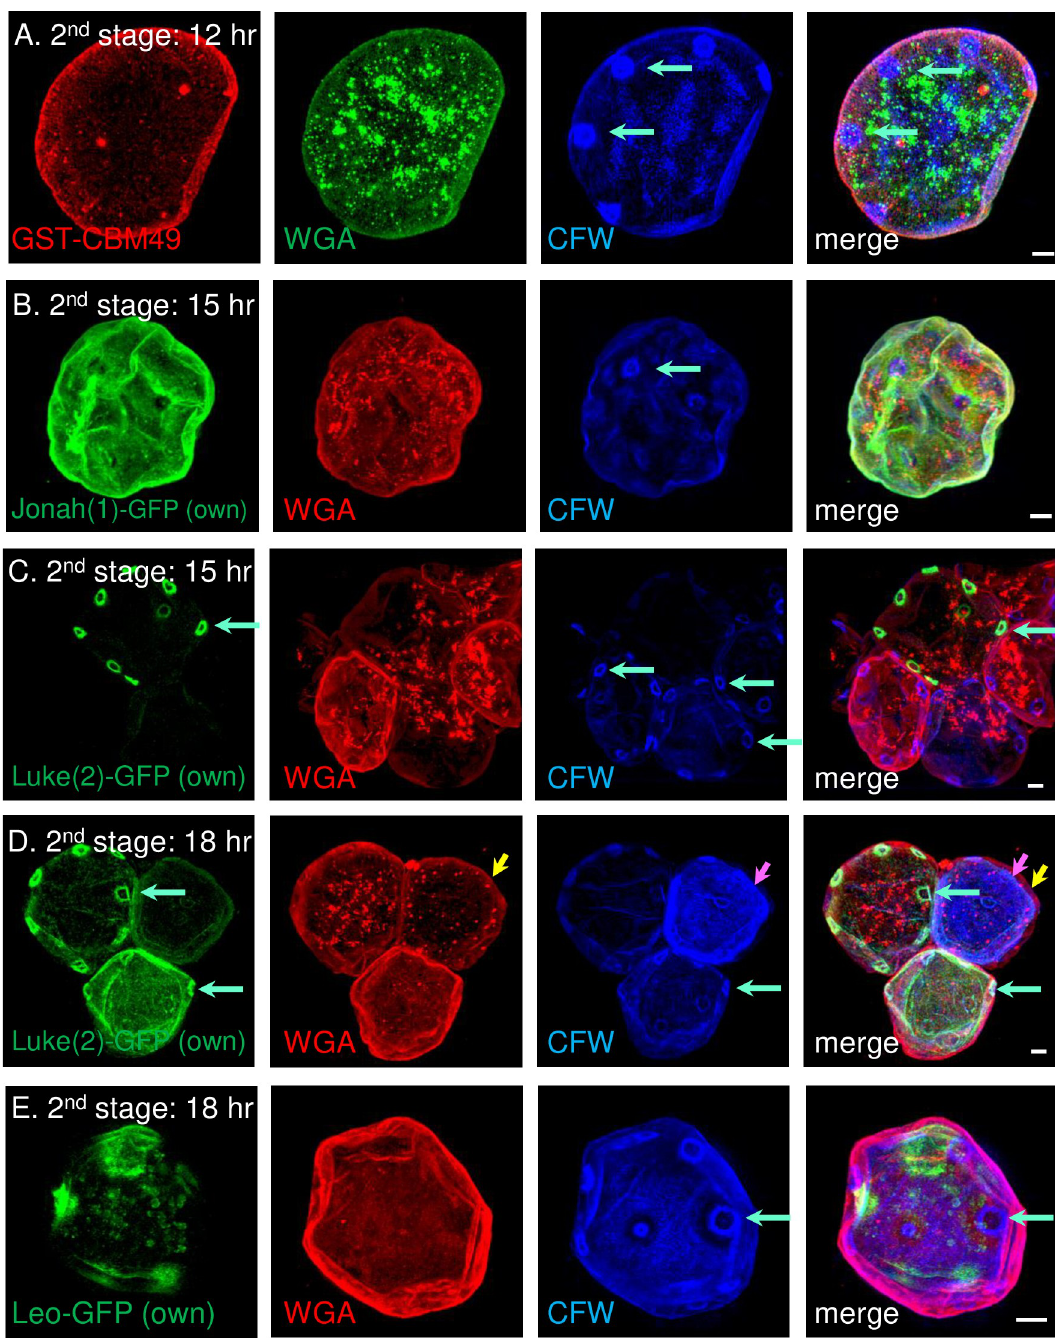
Fig 5. During the second stage of encystation, SIM showed a primordial cyst wall was comprised of Jonah(1)-GFP and glycopolymers labeled with GST-CBM49 and WGA, each in a diffuse pattern, while small, flat ostioles were outlined by Luke (2)-GFP and labeled with CFW. A. After 12 hr encystation, GST-CBM49 (red) diffusely labeled a thin, primordial wall, which contained small, flat ostioles (turquoise arrows) visible only with CFW (blue). WGA (green), which predominantly labeled vesicles, also labeled the thin, primordial wall. After 15 hr encystation, Jonah(1)-GFP (green), expressed under its own promoter, was homogenously distributed in the primordial wall (B), while Luke(2)-GFP (green), also expressed under its own promoter, outlined the edges of small ostioles in some cells (C). After 18 hr encystation, Luke(2)-GFP, which continued to outline the edges of small ostioles, also spread across the surface of some primordial walls (D), while Leo-GFP, expressed under its own promoter, was in a patchy distribution in primordial walls that was, for the most part, independent of ostioles (E). Also at 18 hr in some cells, there were the beginnings of an outer ectocyst layer (yellow arrow) and an inner endocyst layer (pink arrows). A to E. Scale bars are 2 μ m.